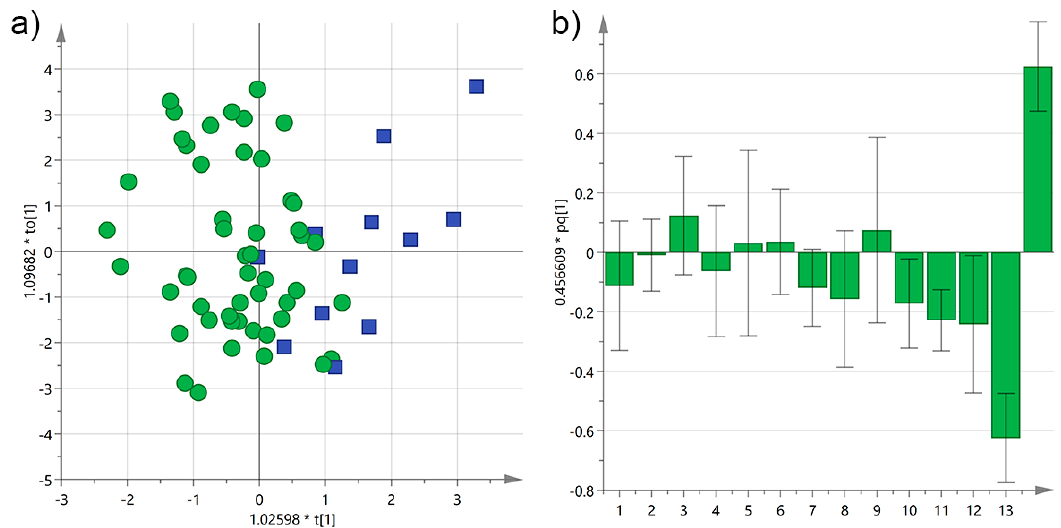
Figure 8. ( a ) OPLS-DA score plot for EVOO samples from Salento categorized by the interval time between harvesting and milling of the olives (green circles ≤ 12 h; blue squares ≥ 12 h); ( b ) OPLS-DA loadings column plot for the first predictive component of the model (variables: 1 = total biophenols; 2 = hydroxytyrosol; 3 = tyrosol; 4 = 3,4-DHPEA-EDA; 5 = 3,4-DHPEA-EA; 6 = lignans; 7 = luteolin; 8 = p -HPEA-EDA; 9 = p -HPEA-EA; 10 = 3,4-DHPEA-EA in the mixed aldehydic and hydroxylic form; 11 = p -HPEA-EA in the mixed aldehydic and hydroxylic form; 12 = α -tocopherol; 13 ≤ 12 h; 14 > 12 h).